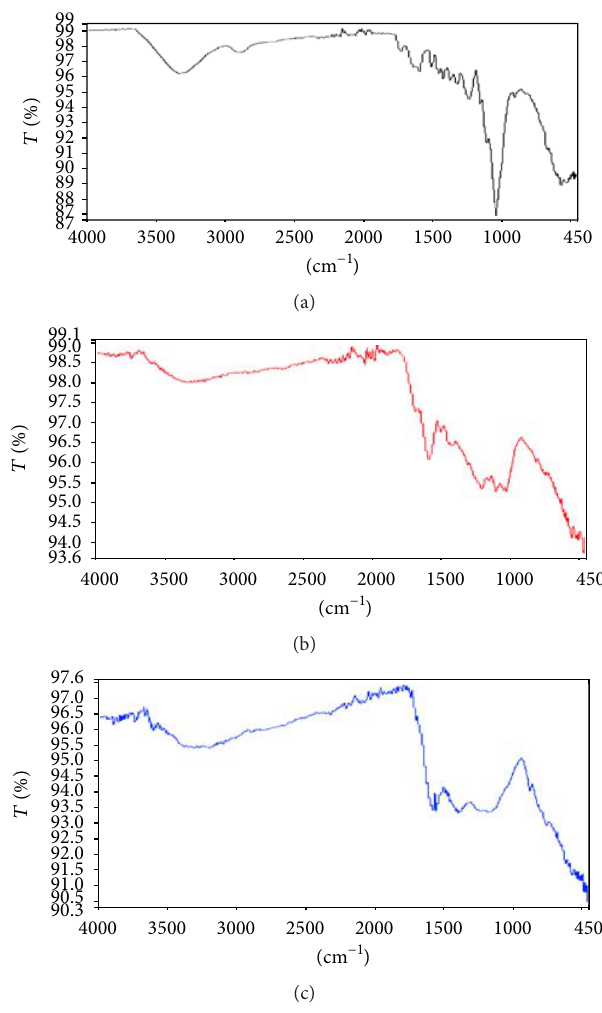
Figure 4: Raw FTIR spectra for dry saw dust (a), carbonized saw dust (b), and carbonized + sulphonated sawdust (c).